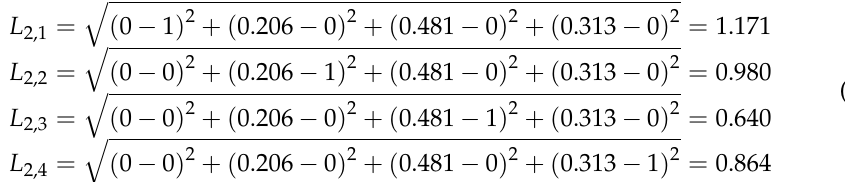
Figure 4. Visual comparison of indicator weights. In the figure, V1, V2, V3, V4, and V5 represent σ c , σ θ / σ c , σ c / σ t , W et , and K V and AHP, EWM, CV, and GT represent the analytic hierarchy process, the entropy method, the coefficient of variation method, and the improved game theory, respectively. The shortest distance d 1 was determined: min